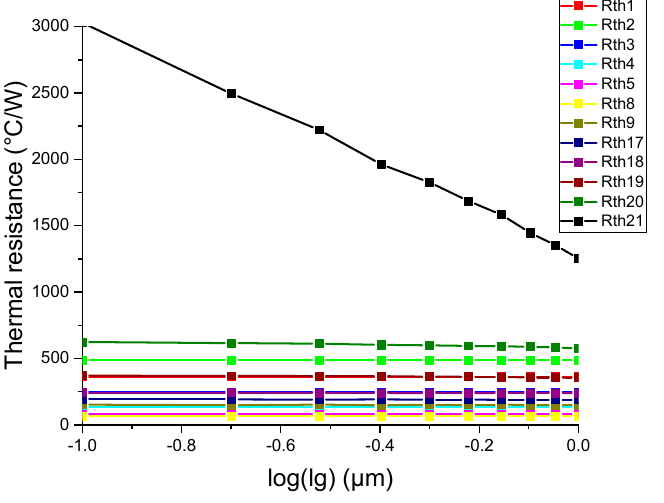
Figure 12. Thermal time constants versus gate length.